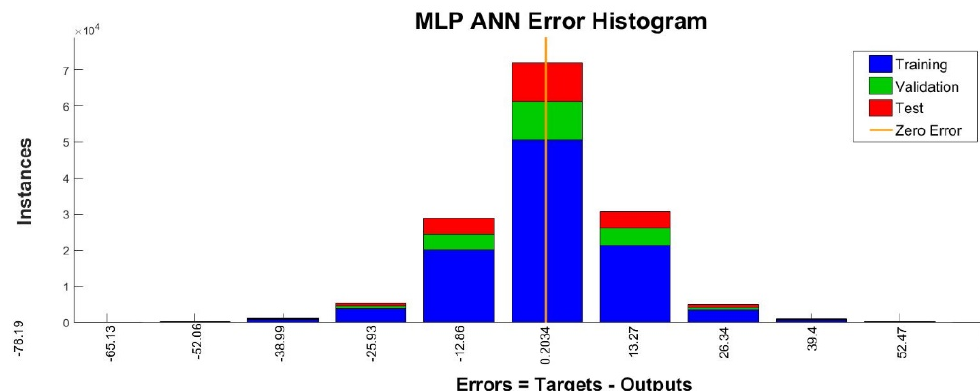
Figure 12. Performance metrics plot for MLP ANN algorithm against different number of hidden layer’s nodes.